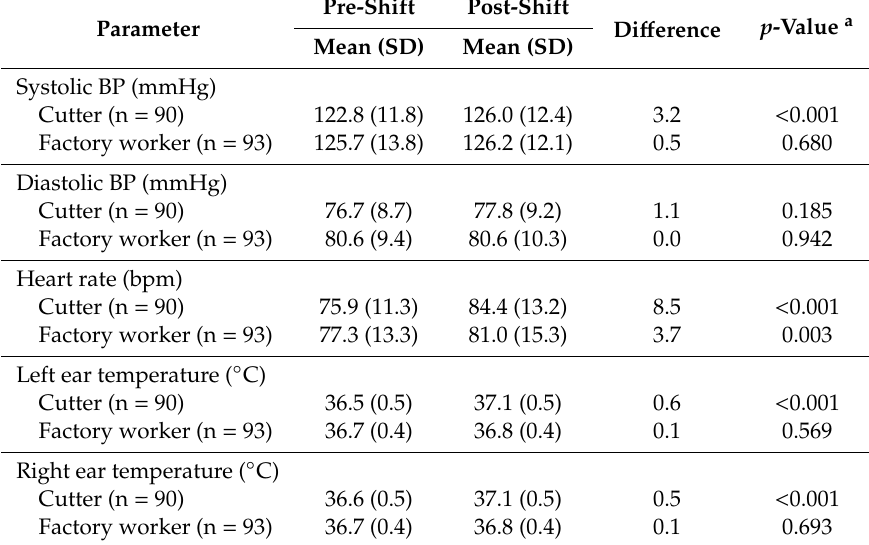
Table 4. Blood pressure (BP), heart rate, and ear temperature of sugarcane workers in the work shift.